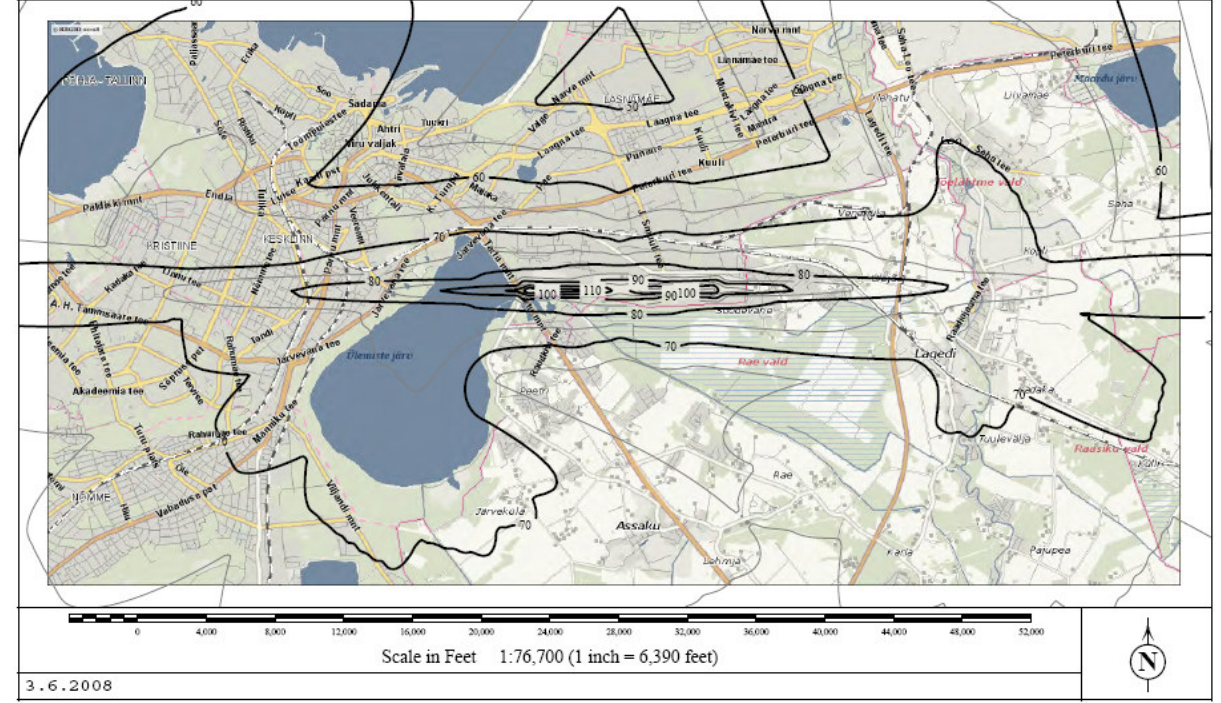
Fig 8. Tallinn Airport. Noise map according to Directive 2002/49/EC. LAmax (23-7) noise contours. 2006 average